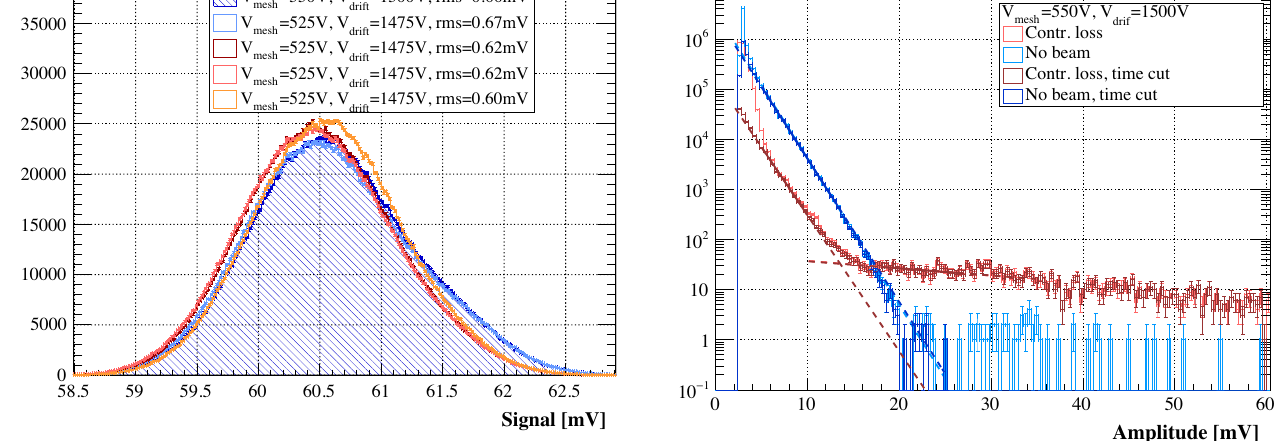
FIG. 12. Amplitude distributions extracted during the con- trolled loss experiment (red) and during an overnight data acquisition where beam was not present (blue). Dark and light colors refer to distributions extracted with and without cut on event start time applied, respectively. The dashed lines in the γ part indicate result of fitting an exponential shape to this region, with solid line marking range of the fit. The red dashed line in the neutron region is drawn to guide the